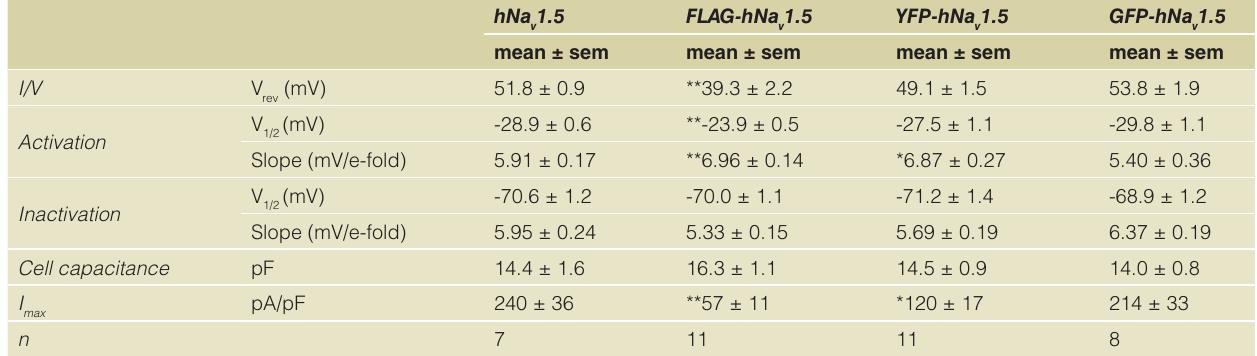
Table 2. Summarized properties of wild-type and tagged hNa 1.5. Data was obtained with current-voltage (I/V)-, and steady-state v inactivation protocols. Mean values and standard errors are shown. *P<0.05, **P<0.01 obtained by two-tailed Student’s t-tests (all statistics were calculated with untagged hNa 1.5 channel as a v